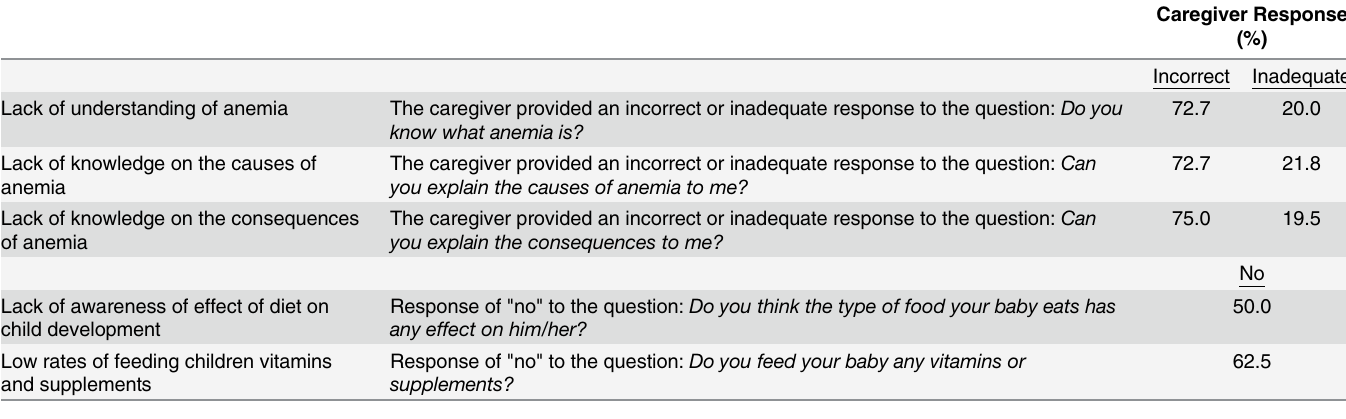
Table 6. Frequency of caregiver interview responses to questions reflecting level of knowledge on topics of nutrition.